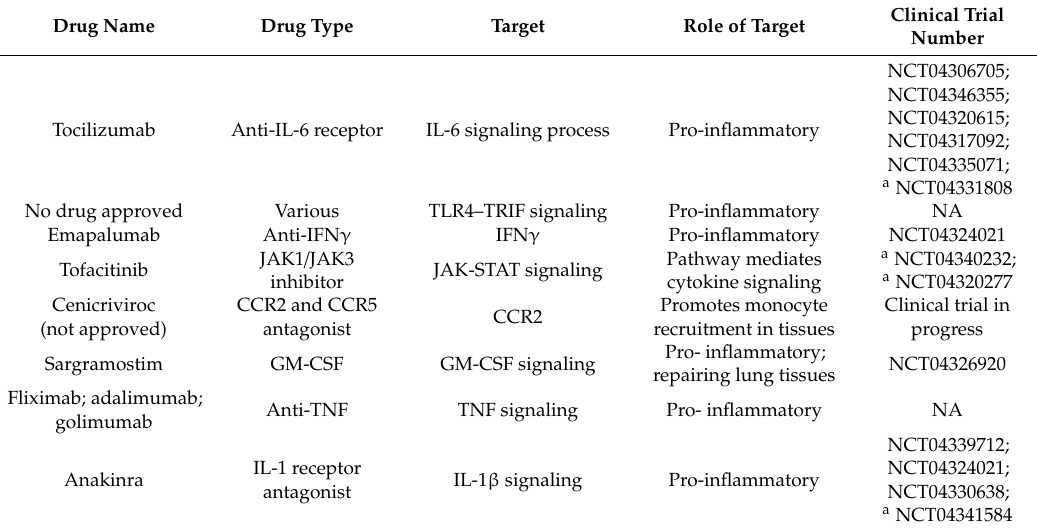
Table 3. Potential therapeutic targets associated with macrophage activation under clinical trials